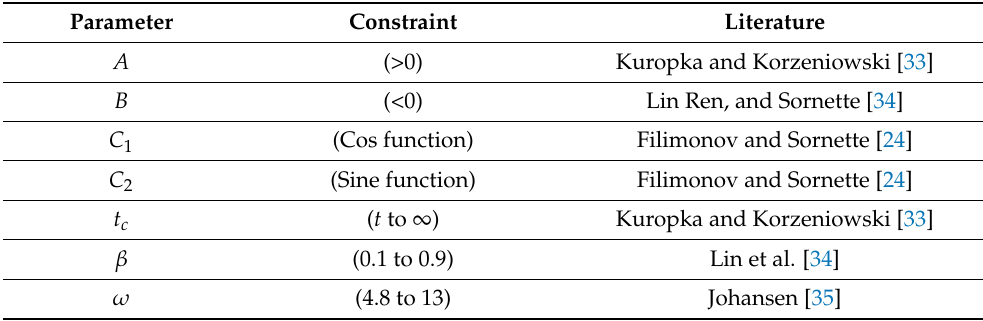
Table 1. Stylized facts (http://finance.martinsewell.com/stylized-facts/ accessed on 28 January 2021) of LPPL.